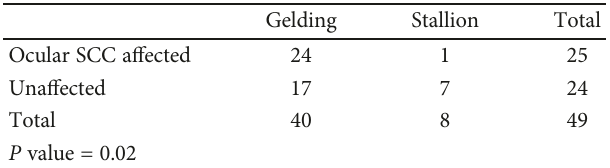
Table 4: Investigating castration status and risk for ocular SCC in a population of Ha fl ingers.